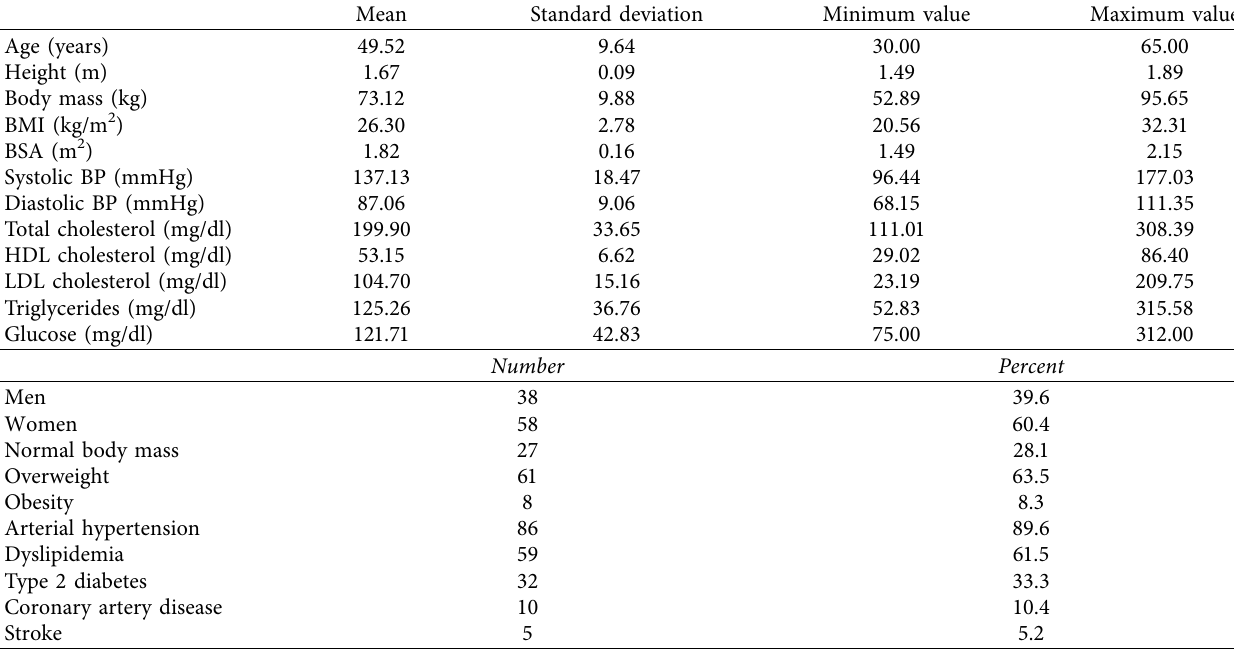
Table 1: Clinical characteristics of the study group.